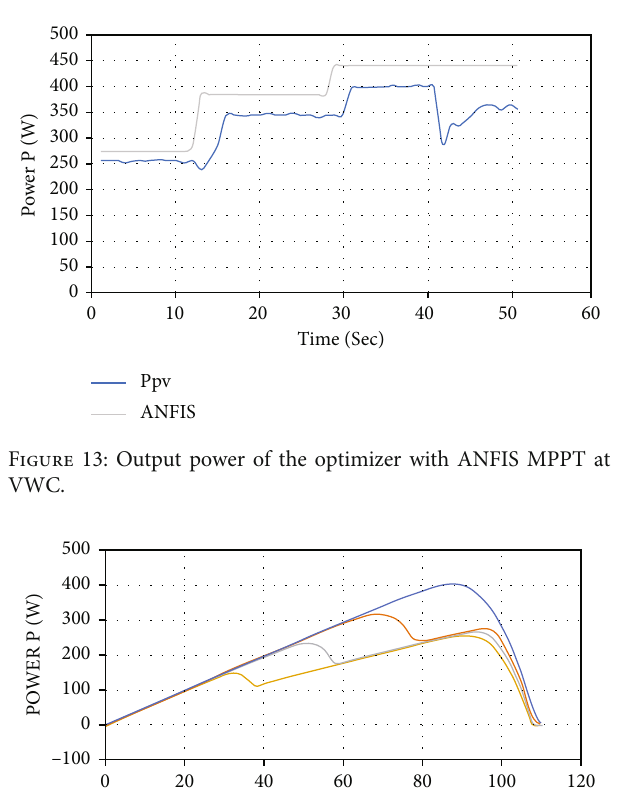
Figure 12: Output power of the optimizer with ANFIS MPPT at STC.